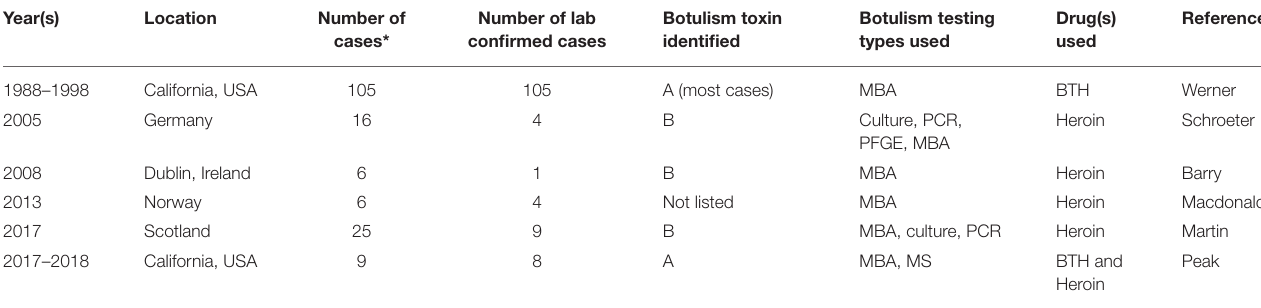
TABLE 1 | Wound botulism outbreaks among persons who inject drugs (PWID). Year(s)